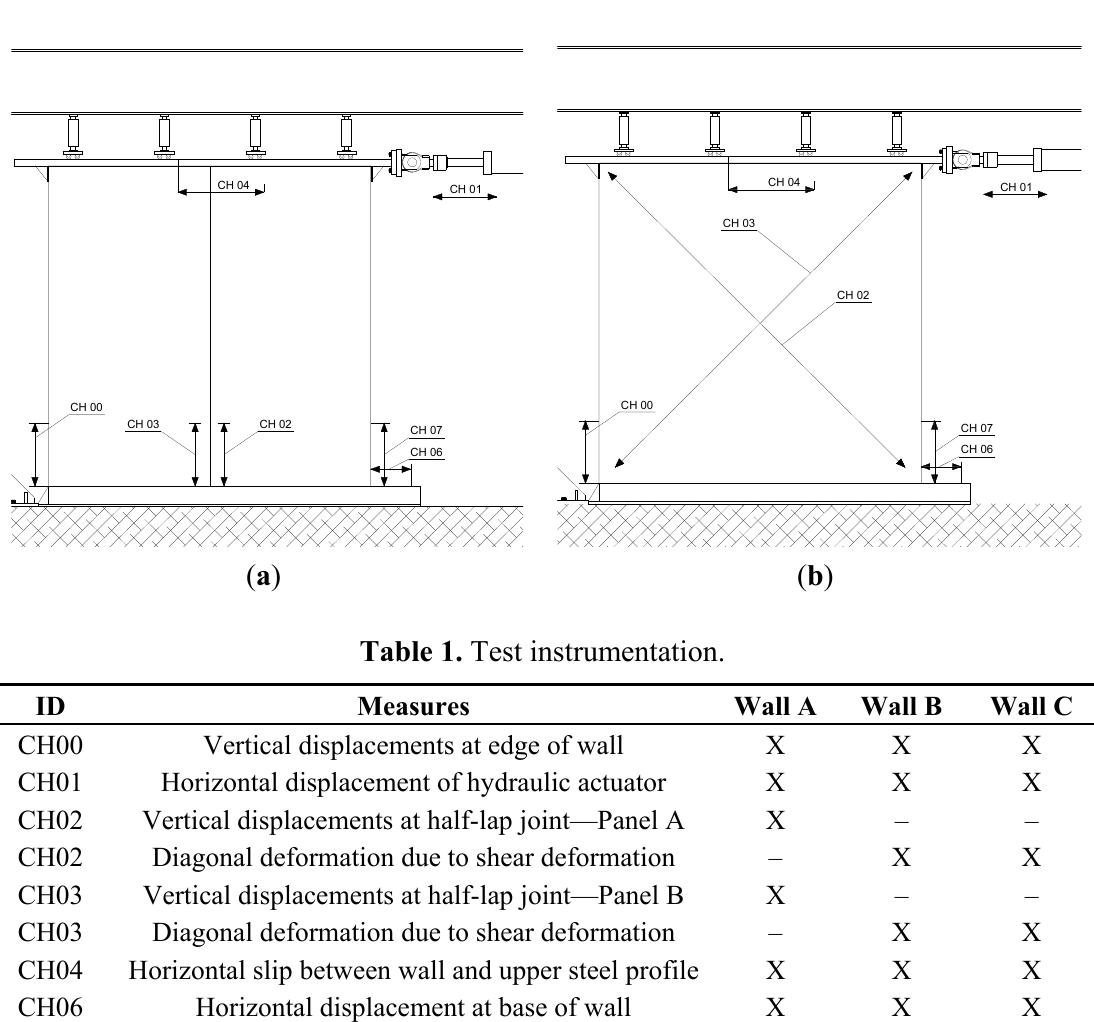
Figure 8. Test instrumentation: ( a ) Wall A; ( b ) Walls B and C.